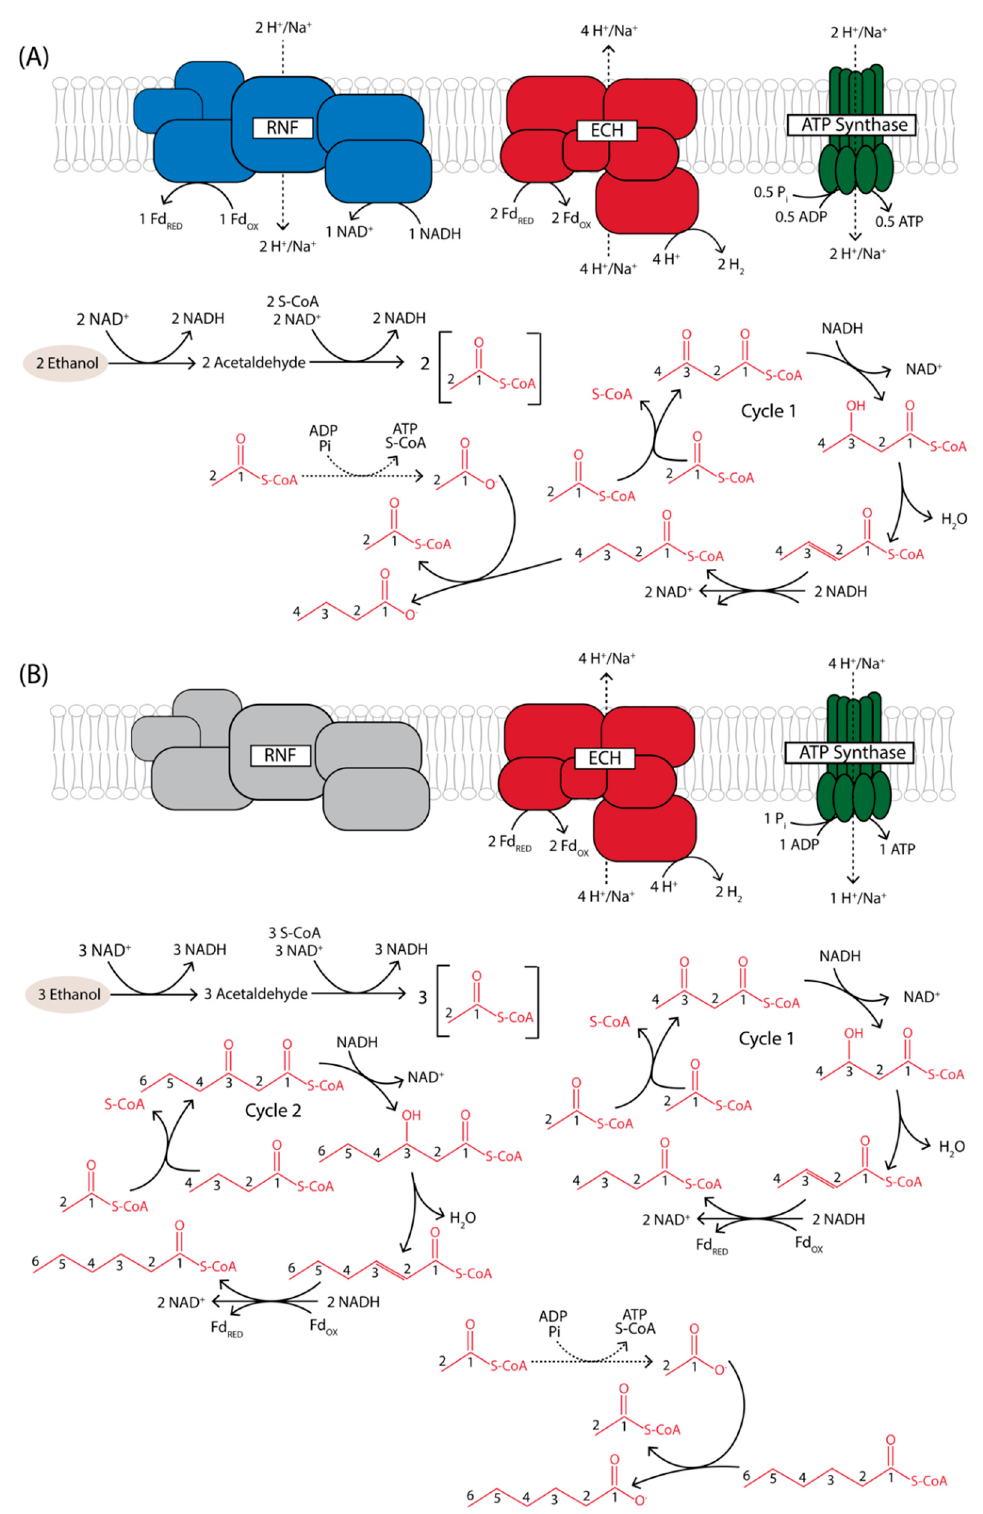
Figure 7. Example models of C4 production ( A ) and C6 production ( B ) when ethanol is used as a sole substrate without acetate as an electron acceptor. The conversion of C6 is predicted to increase the ATP yield per mol of ethanol by 33%.